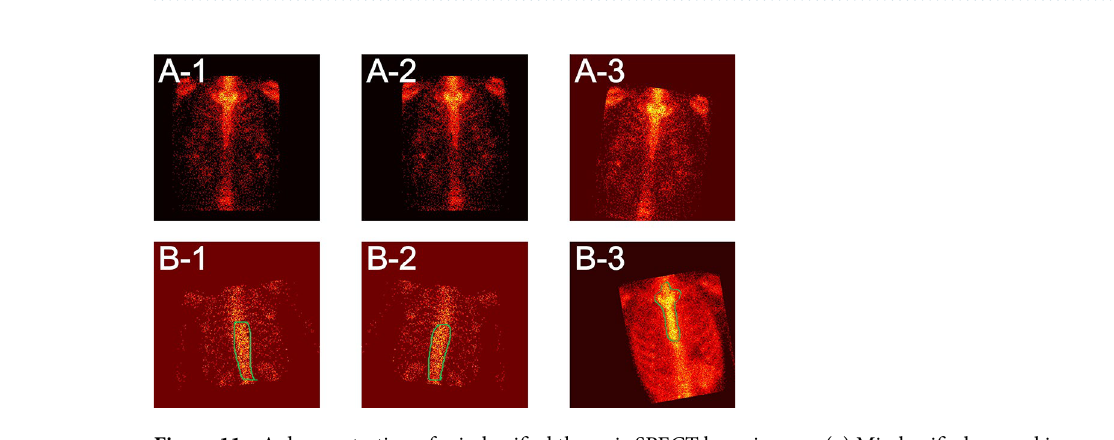
Figure 10. The confusion matrixes obtained by SPECS V21 on: ( a ) Dataset D 2 ; and ( b ) Dataset D 3 .